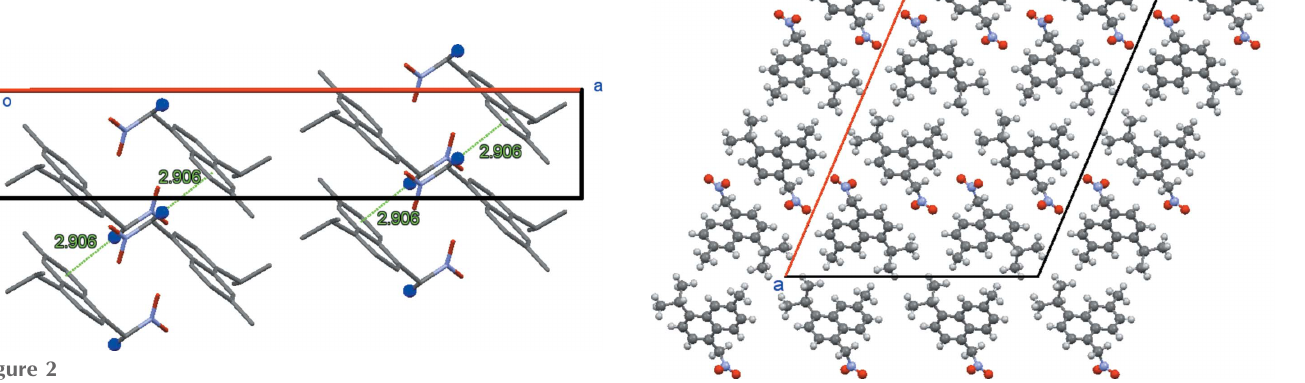
Figure 3 A view along the b axis of the crystal packing.